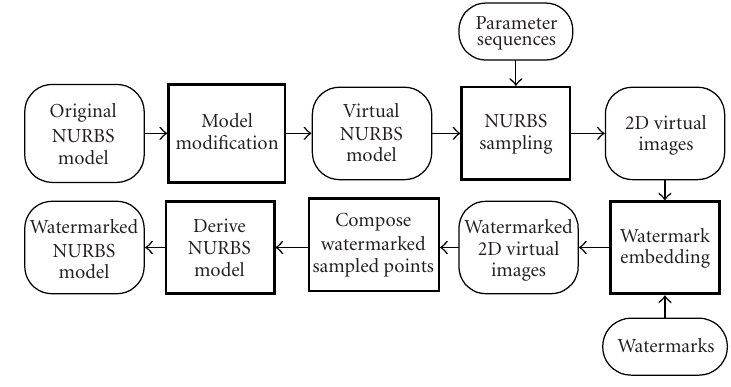
Figure 1: Block diagram of watermarking process using model sampling.